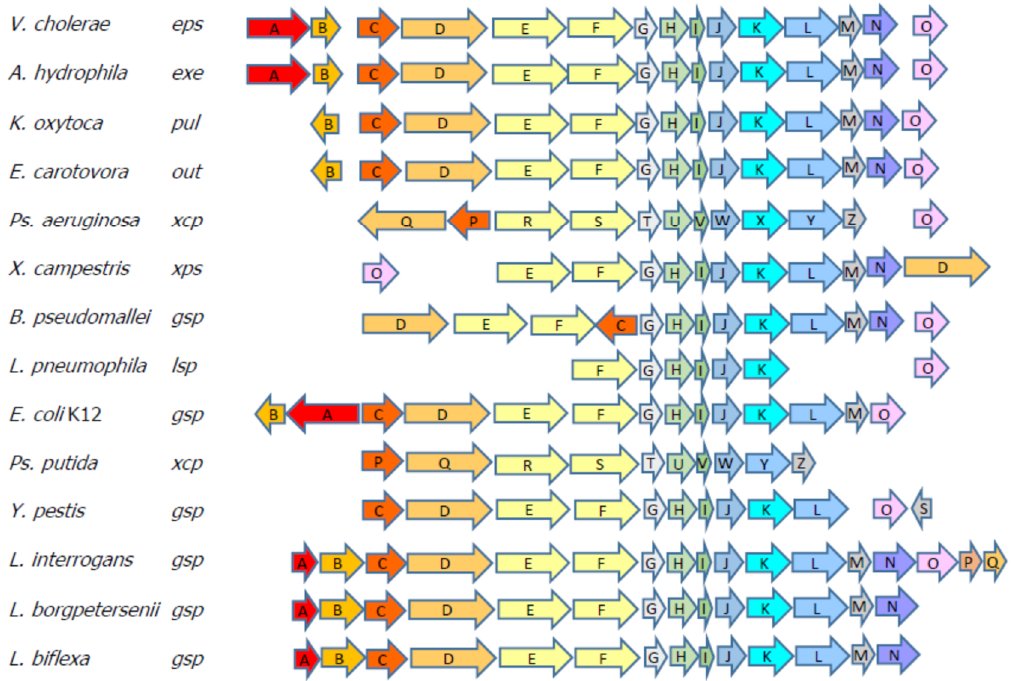
Figure 7. Schematic of the type II secretion system (T2S) loci in different bacteria. L. interrogans shows 17 ORFs in the gsp locus; meanwhile, L. borpetersenii and L. biflexa both show only 14 ORFs in their loci. (Modified from Sandkvist, 2001 [38]).